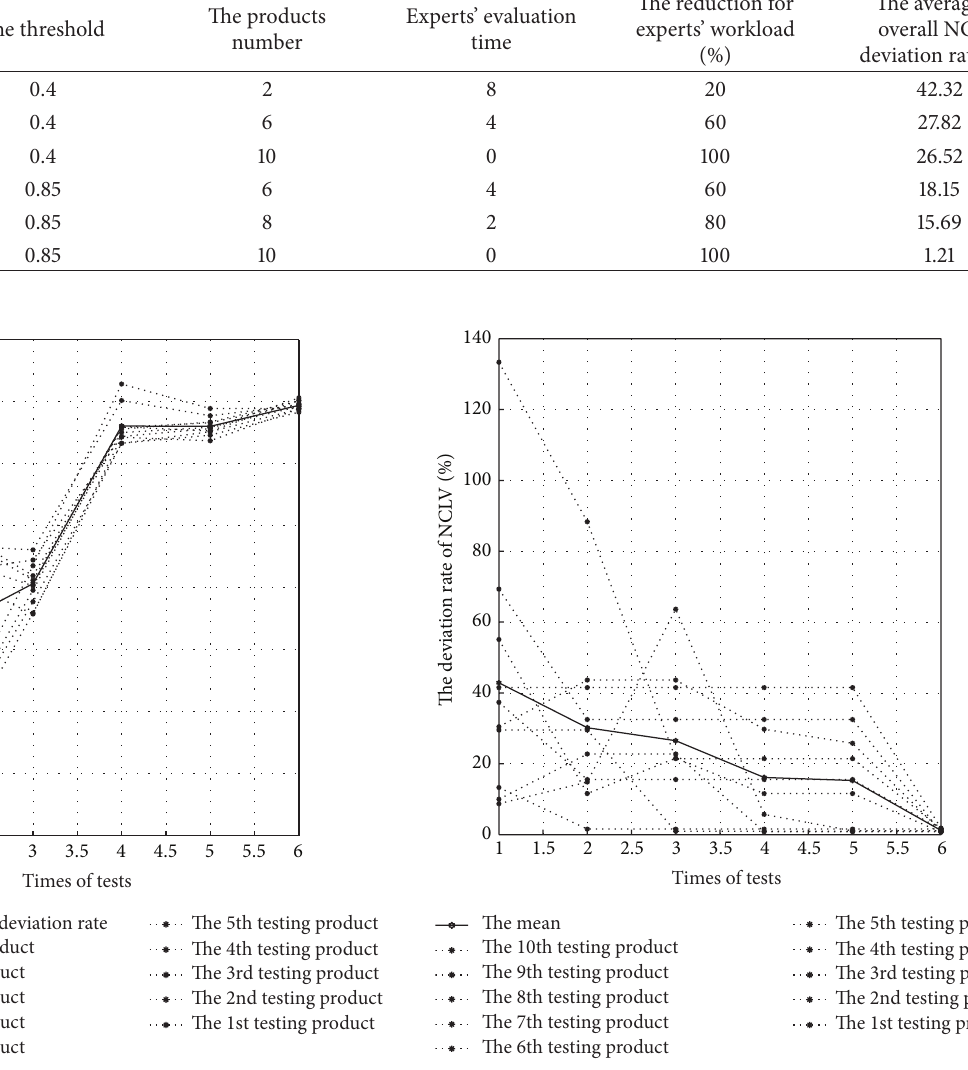
Figure 9: The similarity comparison results of six tests. Figure 10: The comparison results of the NCLV deviation rate of six